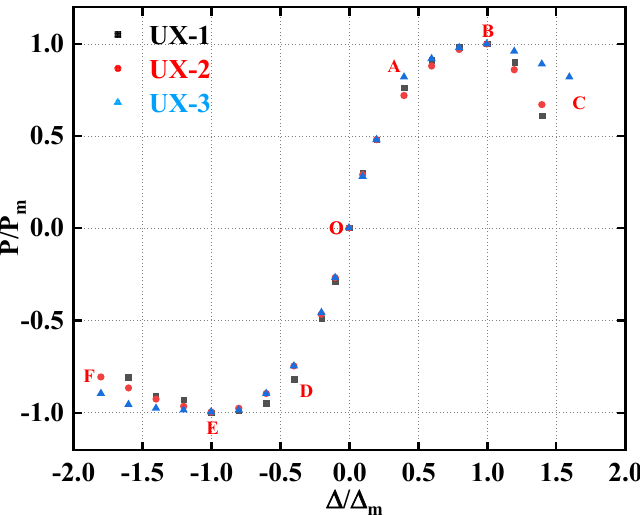
Figure 11. Dimensionless skeleton curve.